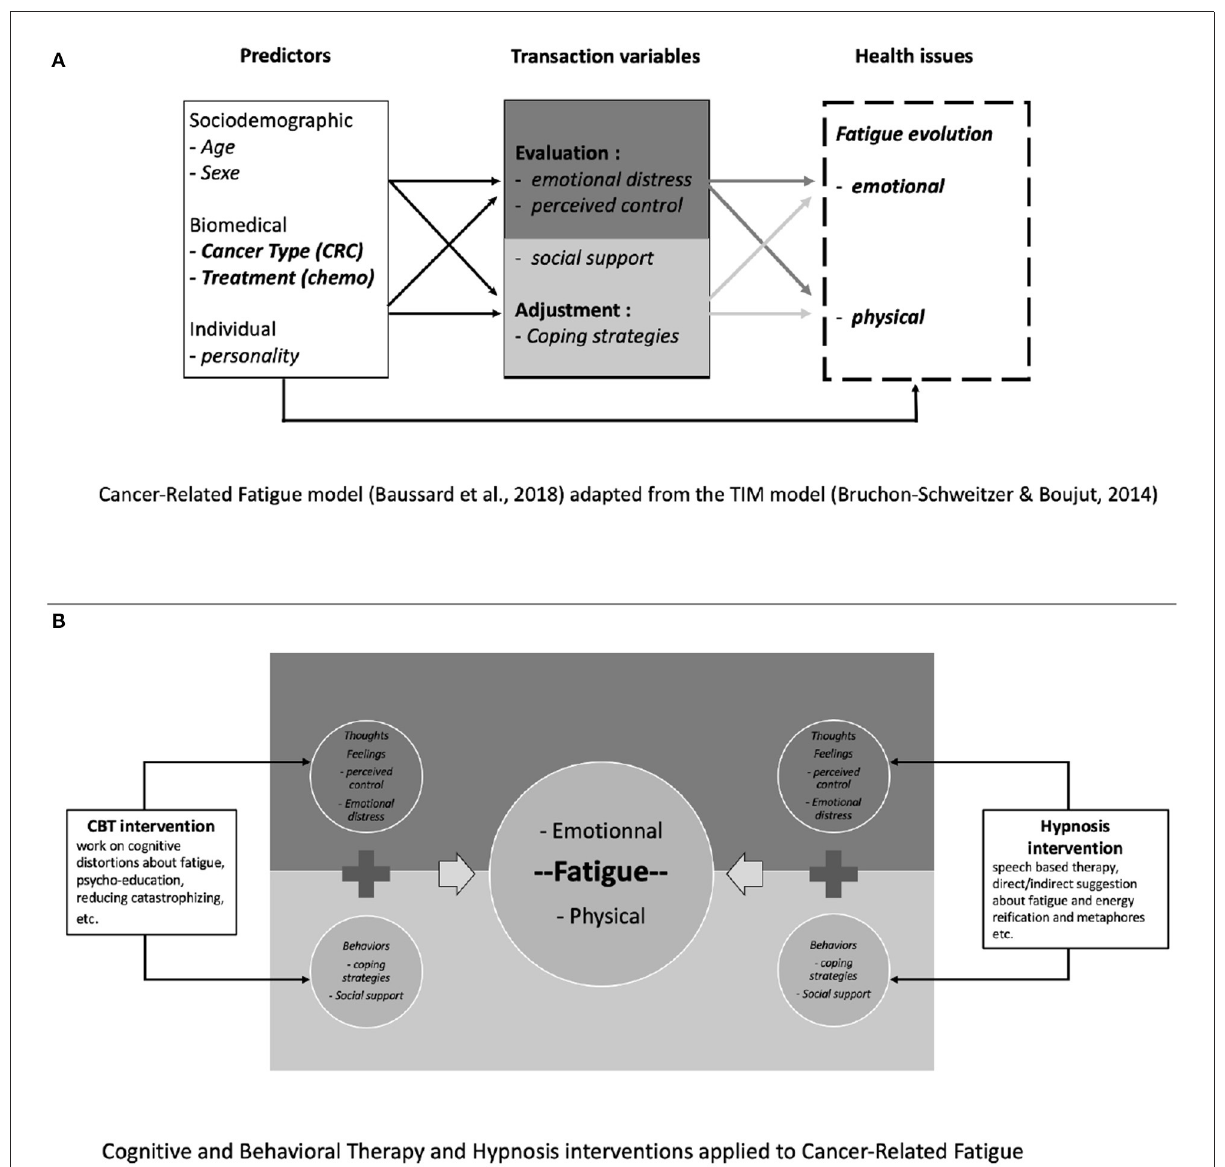
FIGURE1 (A,B) From theory to practice–psychosocial interventions (CBT and hypnosis) applied to the determinants of cancer-related